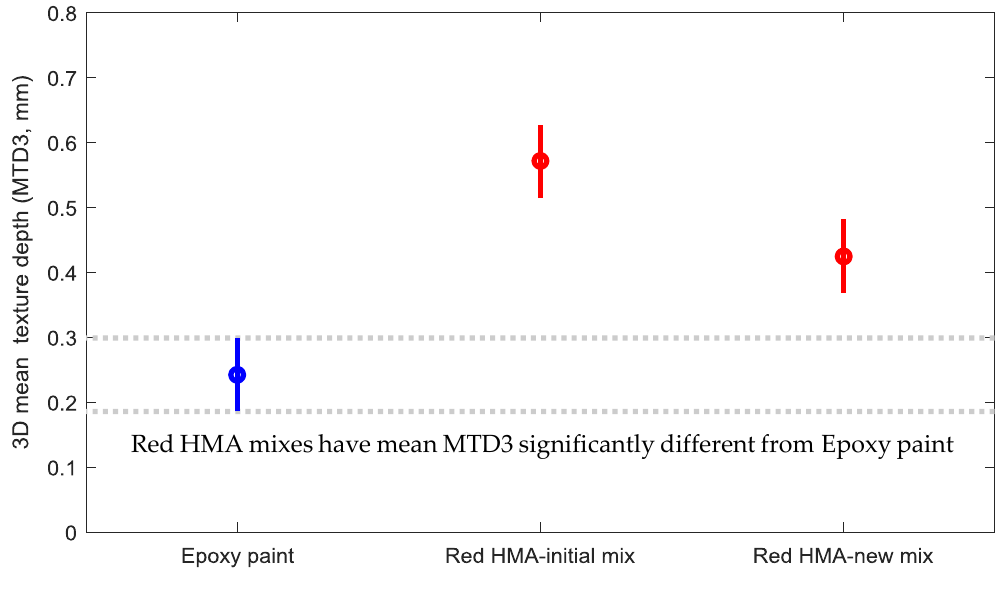
Figure 6. Pavement 3D mean macrotexture depths of tested sections.